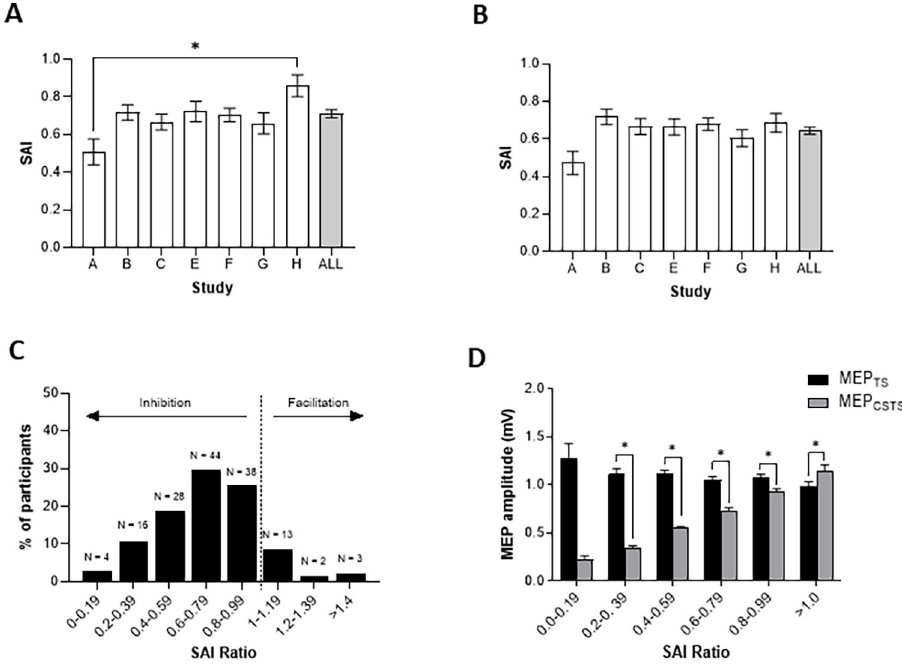
Fig 1. Distribution of SAI data for individual studies and data from all studies. SAI values from each of the studies included in the main analyses are shown with (A; n = 148) and without (B; n = 130) instances where no inhibition (ratios > 1) occurred. The distribution of pooled SAI data (n = 148) is shown in C, and MEP CSTS (gray) and MEP TS (black) amplitudes are shown in D (also n = 148) for 20% bins between SAI = 0 and SAI = 1.0, and for SAI > 1.0. � p < 0.01 significant result of a Mann-Whitney U post-hoc comparison between study A and study H (A). � p < 0.01 significant difference indicated by Wilcoxon signed rank tests and for paired comparisons of MEP CSTS and MEP TS amplitudes within each bin (D). All error bars represent the mean and standard error of the mean.